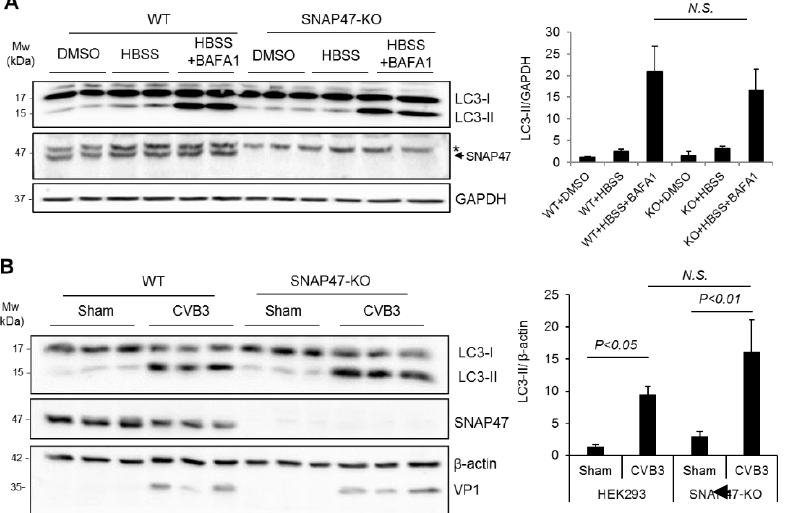
Figure 3. Ablation of SNAP47 does not impair starvation- or CVB3-induced autophagy. ( A ) Wildtype (WT) and SNAP47-knockout (KO) HEK293T cells were starved in HBSS medium in the presence or absence of a lysosomal inhibitor bafilomycin A1 (BAFA1, 200 nM) for 6 h. Western blot analysis was conducted to probe for SNAP47, LC3, and GAPDH. * Indicates non-specific bands. Arrow denotes the location of SNAP47 protein band. ( B ) WT and SNAP47-KO HEK293T cells were infected with CVB3 at an MOI of 100 for 8 h. Western blotting was performed to detect SNAP47, LC3, and β –actin/VP1. LC3-II/GAPDH ( A ) and LC3-II/ β –actin ( B ) were quantified by densitometry analysis and are presented as a bar graph (mean ± SEM, n = 3). N.S., not significant.